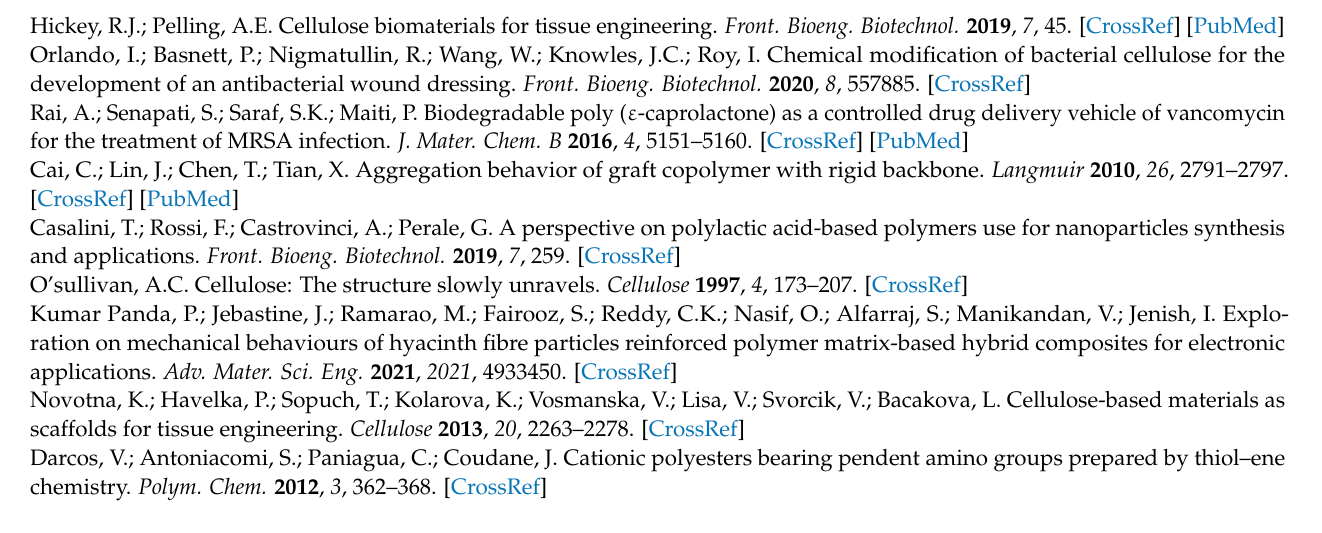
Figure S3: DSC traces of compounds 9 (a), 10 (b), 11 (c), 12 (d), 13 (e), 14 (f); Figure S4: X-ray diffractograms of the compounds 9 (a), 10 (b), 11 (c), 12 (d), 13 (e), 14